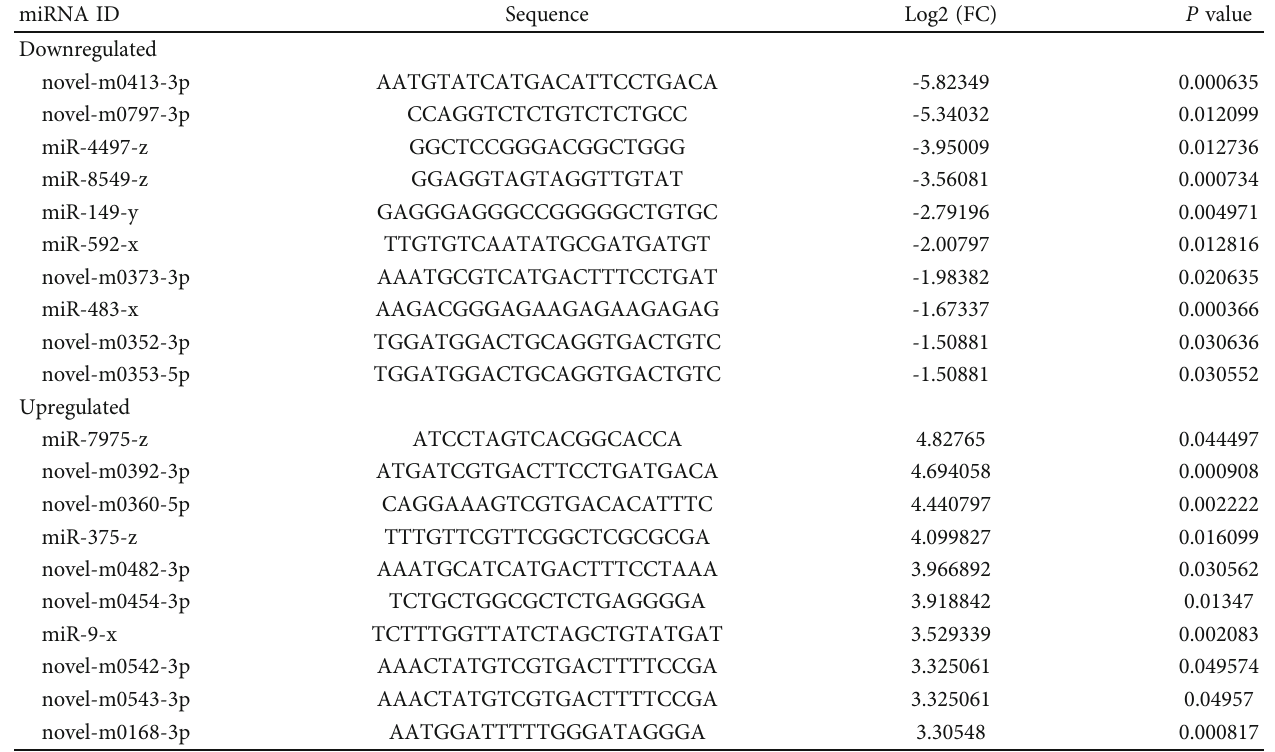
Table 2: Top 10 downregulated and upregulated miRNAs in the treatment